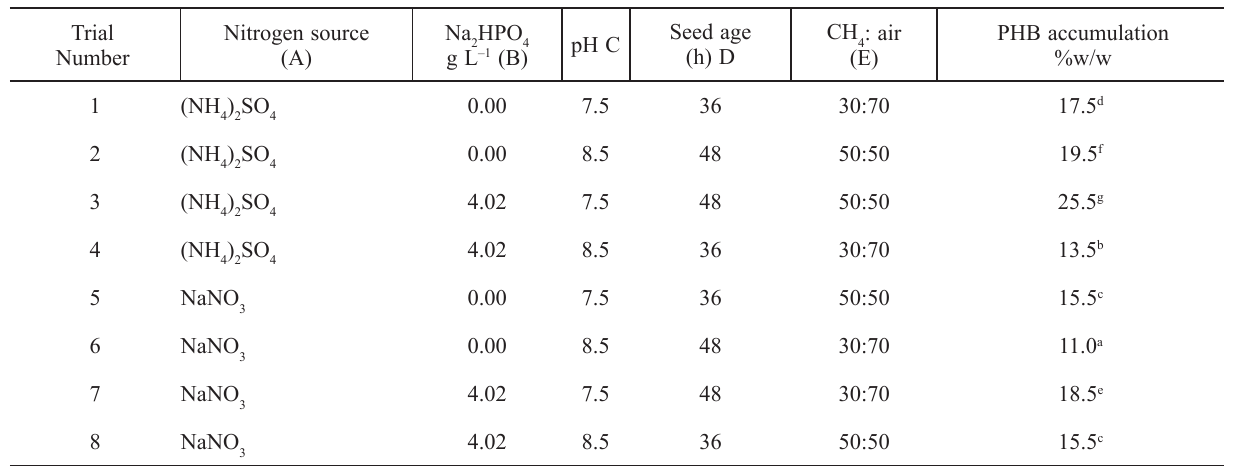
Table 2 – L Orthogonal array for PHB production in a bubble column bioreactor by the isolated methanotroph 8 Trial